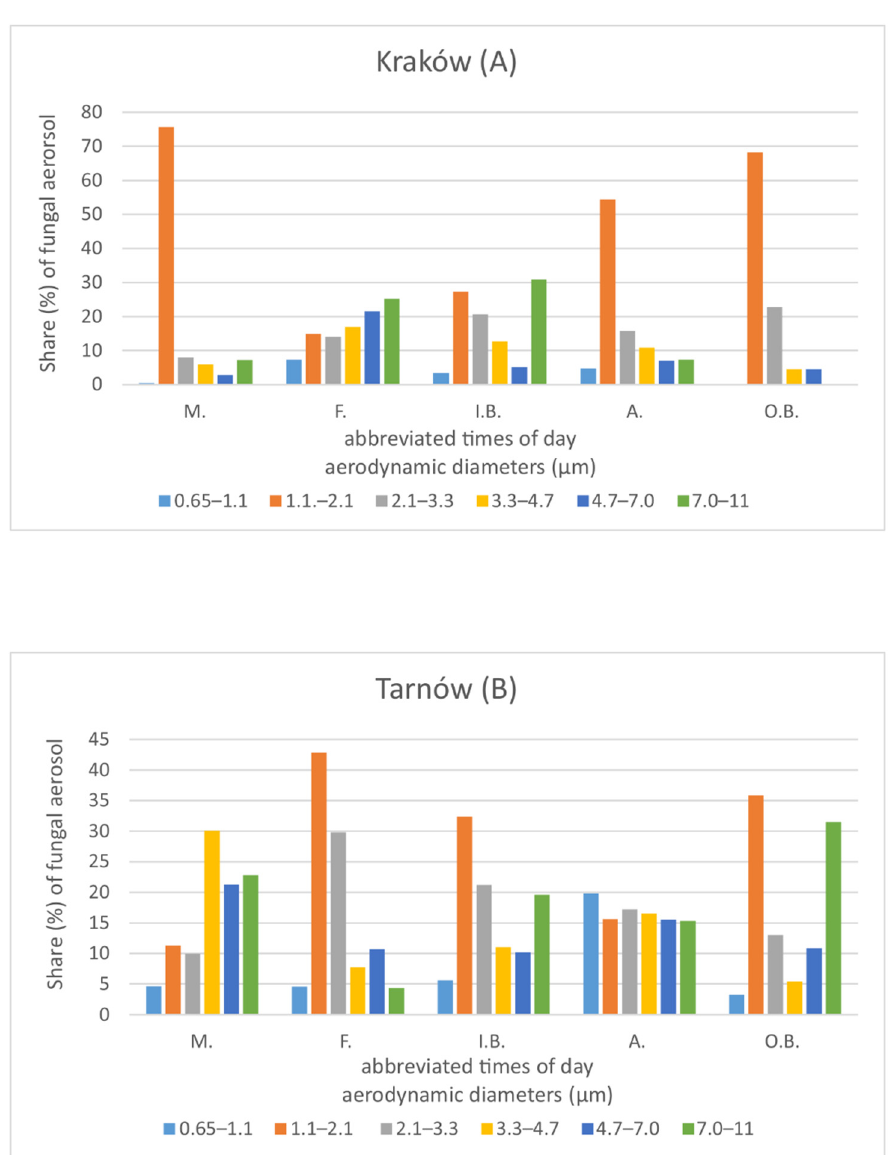
Figure 2. Share (%) of different aerodynamic diameters of airborne fungi in the Kraków ( A ) and Tarnów ( B ) horse stables at different times of the day (M—early morning-no activity; F—feeding; I.B.—indoor background, mid-day; A—afternoon, animals return; O.B.—outdoor background).